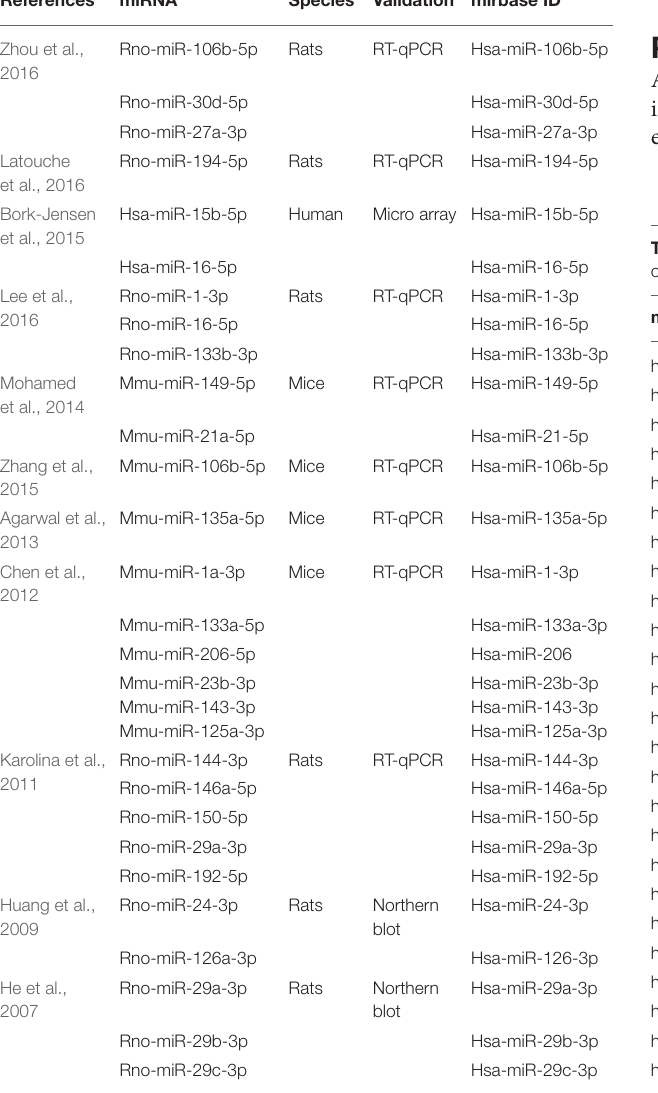
TABLE 1 | List of studies and miRNAs, previously demonstrated to be associated with skeletal muscle insulin sensitivity, that met the initial selection criteria of the current study.